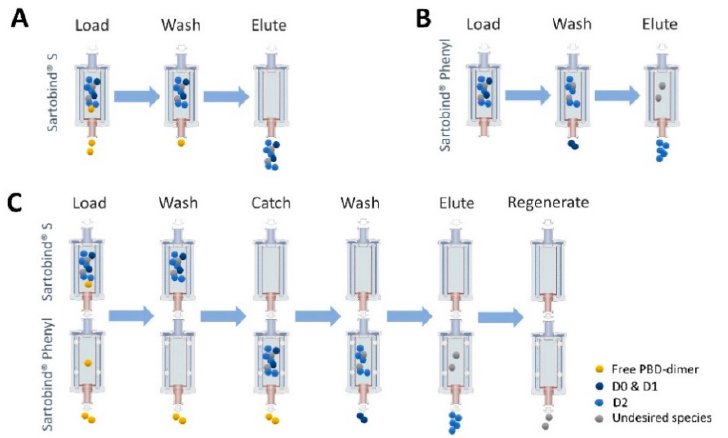
Figure 9. Process-diagram overview. ( A ) Bind/Elute using Sartobind ® S to remove residual payload. ( B ) Bind/Elute using Sartobind ® Phenyl to remove aggregate in stand-alone model. ( C ) Simplified process to purify target ADC with Sartobind S and Phenyl in tandem model.